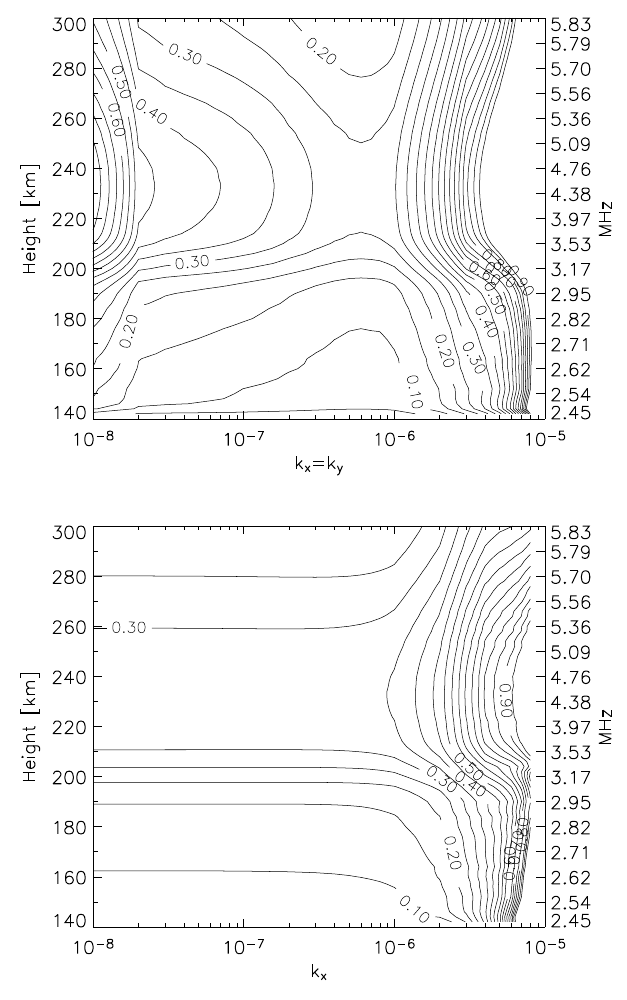
Fig. 10. The Doppler shift ( V ∗ in Hz) for a 5mHz ULF wave with 10% fast mode mix (at 1000km altitude) as a function of altitude. The right hand side axis shows the HF “reflection” frequencies for the ionosphere above Tromsø for 05:00 UT, 24 March 2001. Top: Variation for k x = k y and Bottom: for k y = 1 . 5 × 10 − 6 m − 1